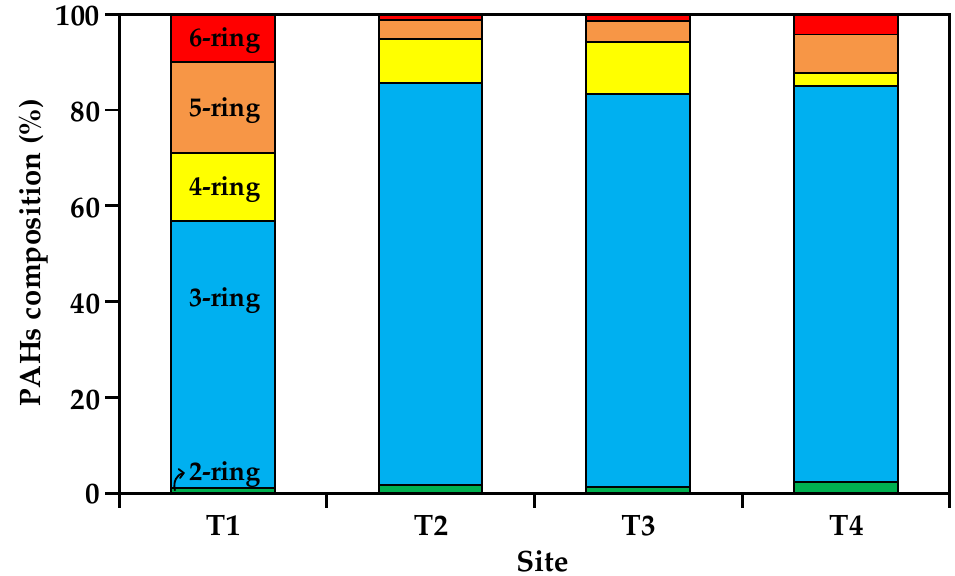
Figure 4. Distribution of composition percentage of two- to six-ring PAHs.